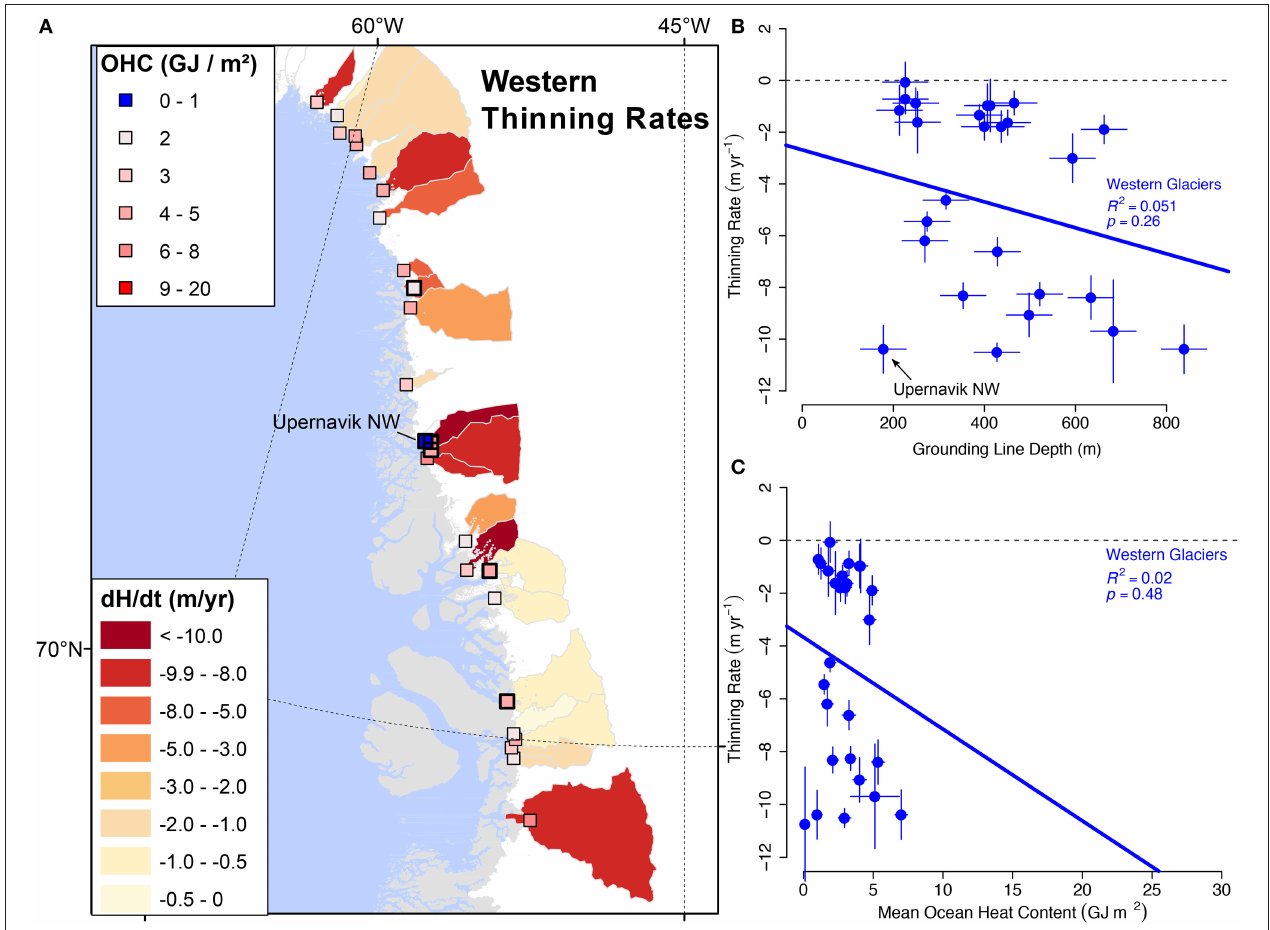
FIGURE 5 | (A) Annualized dynamic thinning rates (dH/dt) and modeled OHC for the period 2003–2009 for Western tidewater glaciers. (B) OLS regression of grounding line depth (m) with the maximum dynamic thinning rate for each catchment ( m yr − 1 ). Scatterplot shows Western glaciers as blue points. Same for (C) except with ocean heat content (OHC) in GJ m − 2 as the independent variable. The coefficient of determination R 2 shown for Western